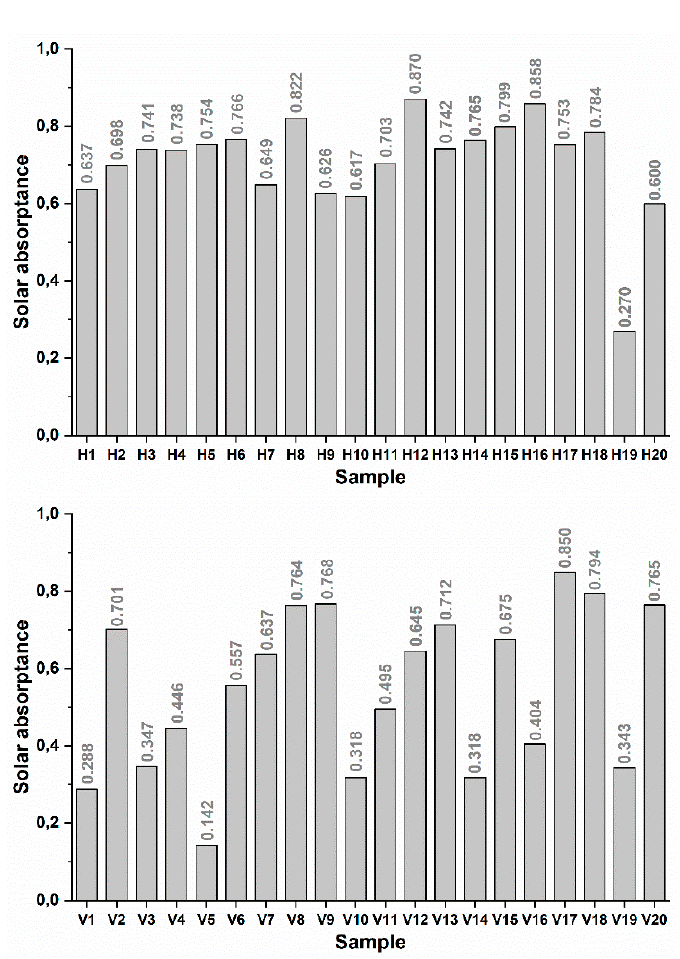
Figure 4. Solar absorptance of the materials analyzed in situ. Top : horizontal surface finishes. Bottom : vertical surface finishes.